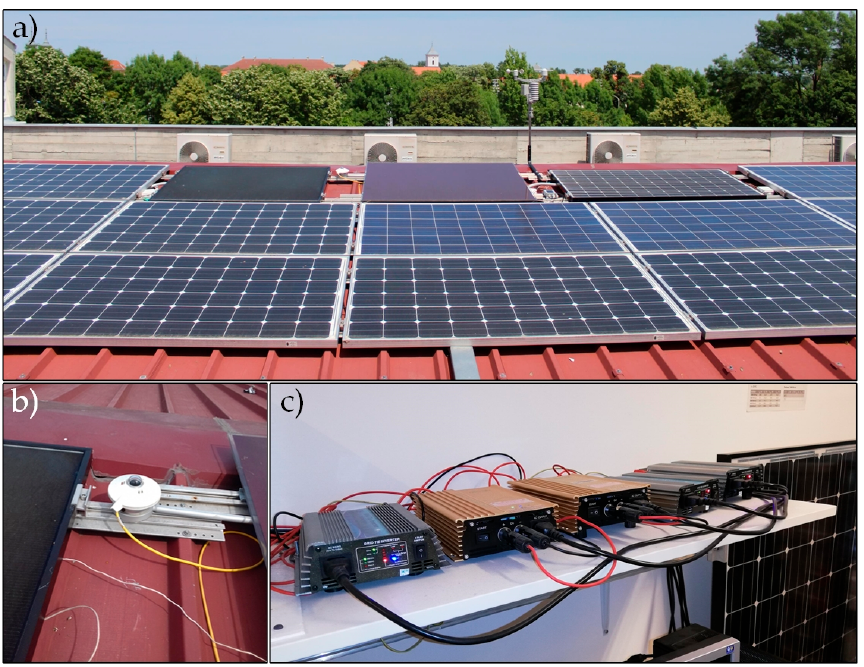
Figure 3. PV modules ( a ), pyranometer ( b ), and micro grid-tie inverters ( c ) of the DAQ system.